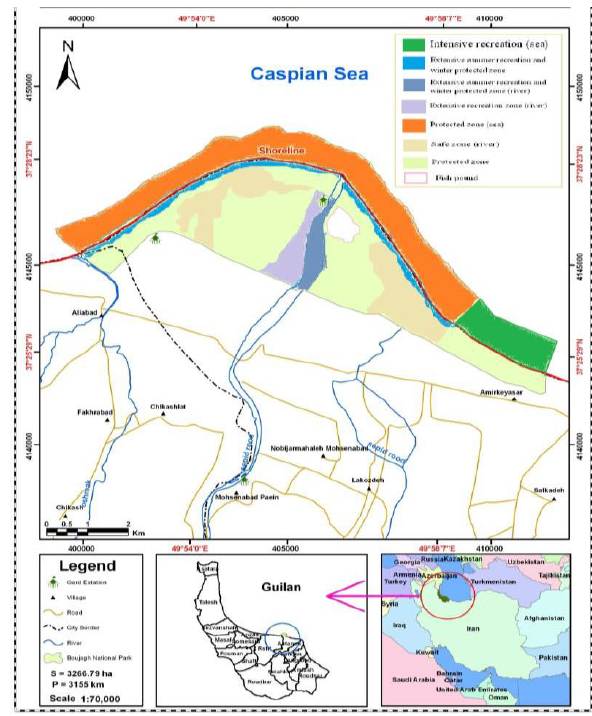
Fig. 9: Zoning of key environmental management strategies of Boujagh Wetland